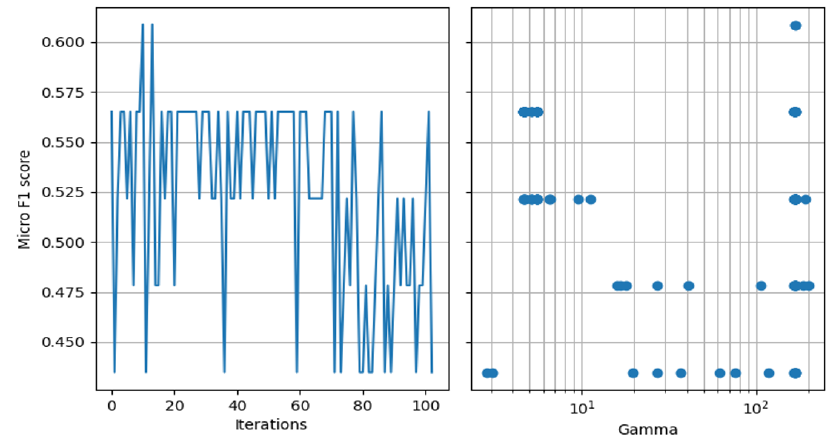
Figure 8. Bayesian optimization results with one free variable.